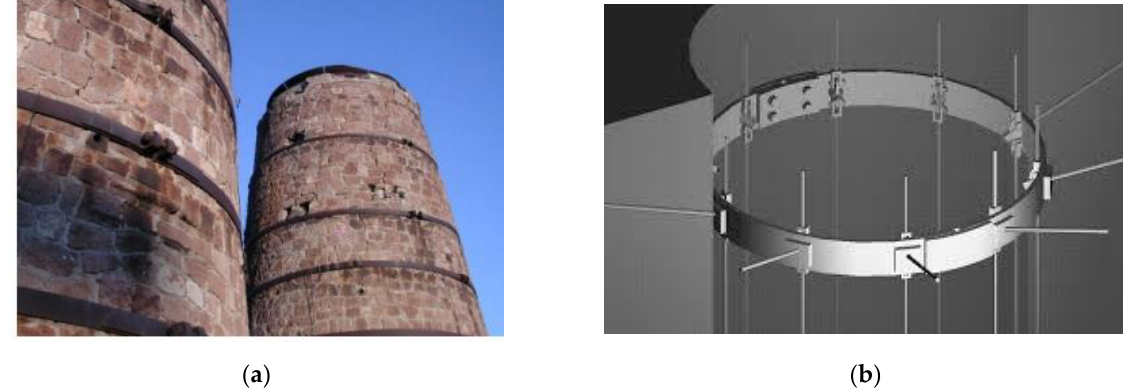
Figure 1. The use of steel reinforcements rings to improve the seismic behavior of slender masonry constructions (invasive modification of the original structure (solution 1). ( a ) Outer reinforcement, and ( b ) inner reinforcement.